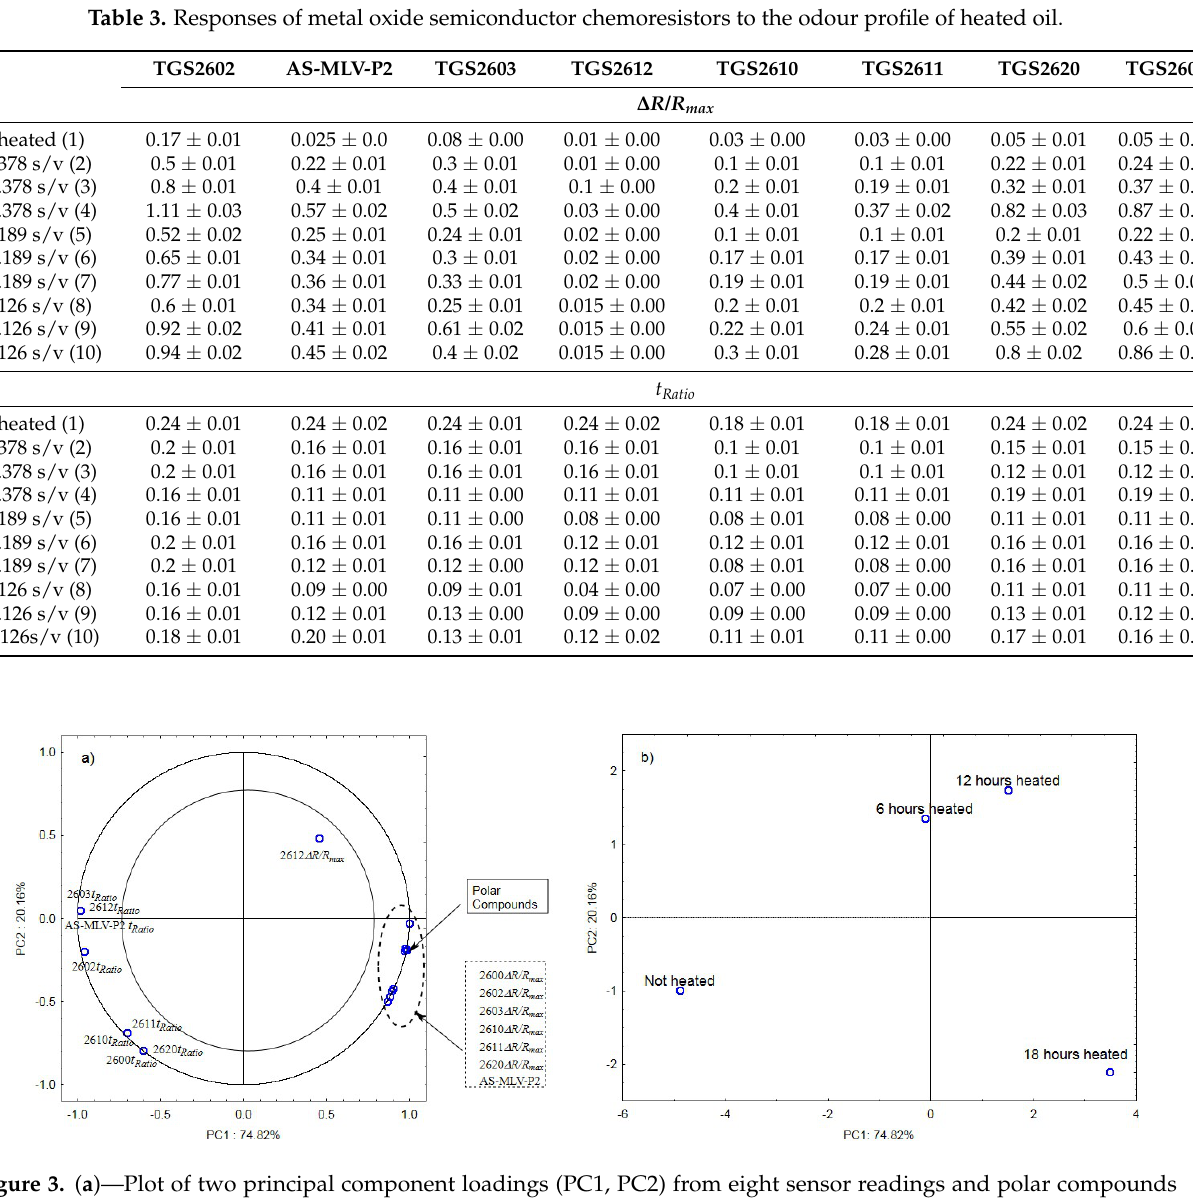
Figure 4. ( a )—Plot of two principal component loadings (PC1, PC2) from eight sensor readings and polar compounds obtained for heated (0.189 s/v ratio) and control oil samples ( ΔR/R max , t Ratio ; AS brief names of sensors—AS-MLV-P2; 2600, 2602, 2603, 2610, 2611, 2612, 2620—brief names of sensors Figaro—TGS series); ( b )—Plot of two principal component scores (PC1, PC2) from eight sensor readings and polar compounds obtained for heated (0.189 s/v) and control oil samples. Figure 5a,b show the results of the principal component analysis for oils with the 0.126 s/v ratio. Figure 5a is a projection of loadings on the PC1 and PC2 planes, which shows a significant positive correlation between the maximum sensor responses and changes in the content of polar compounds as a function of the frying time and a negative correlation with the time ratio. In this case, the projection of loadings on the PC1 and PC2 planes differentiates the heated samples from the control sample (PC1) and the heating time (PC2) (see Figure 5b).